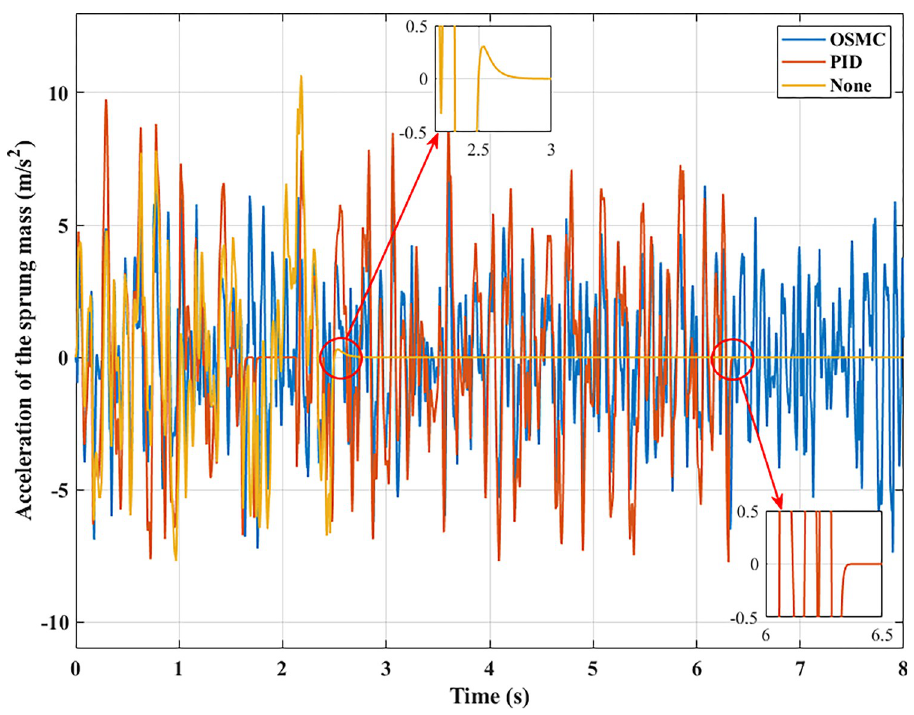
Fig 12. Acceleration of the sprung mass (case